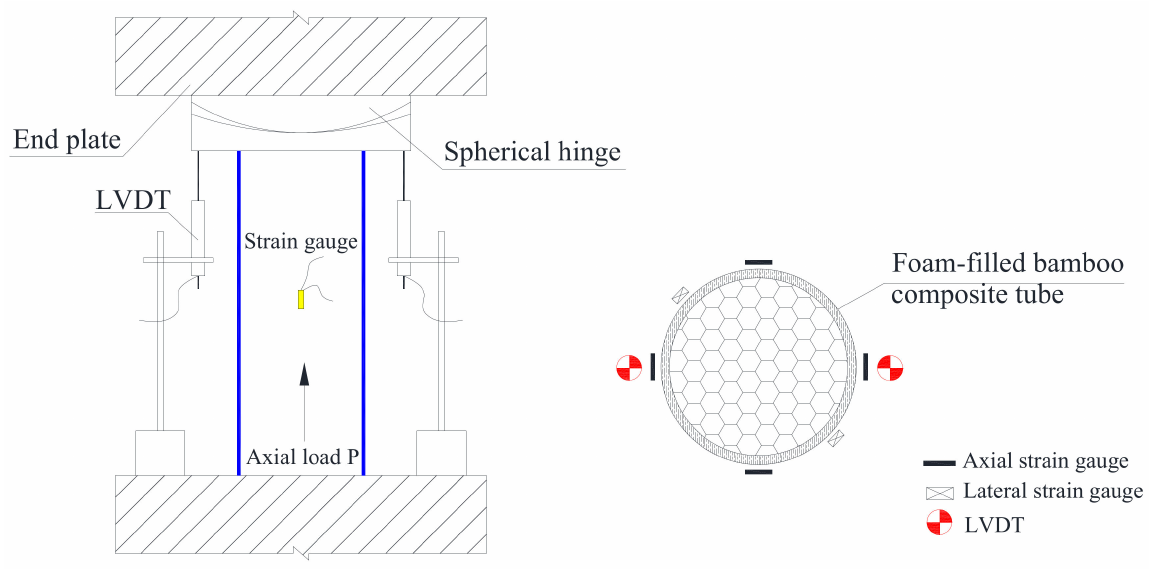
Figure 3. Layout of the test equipment and strain